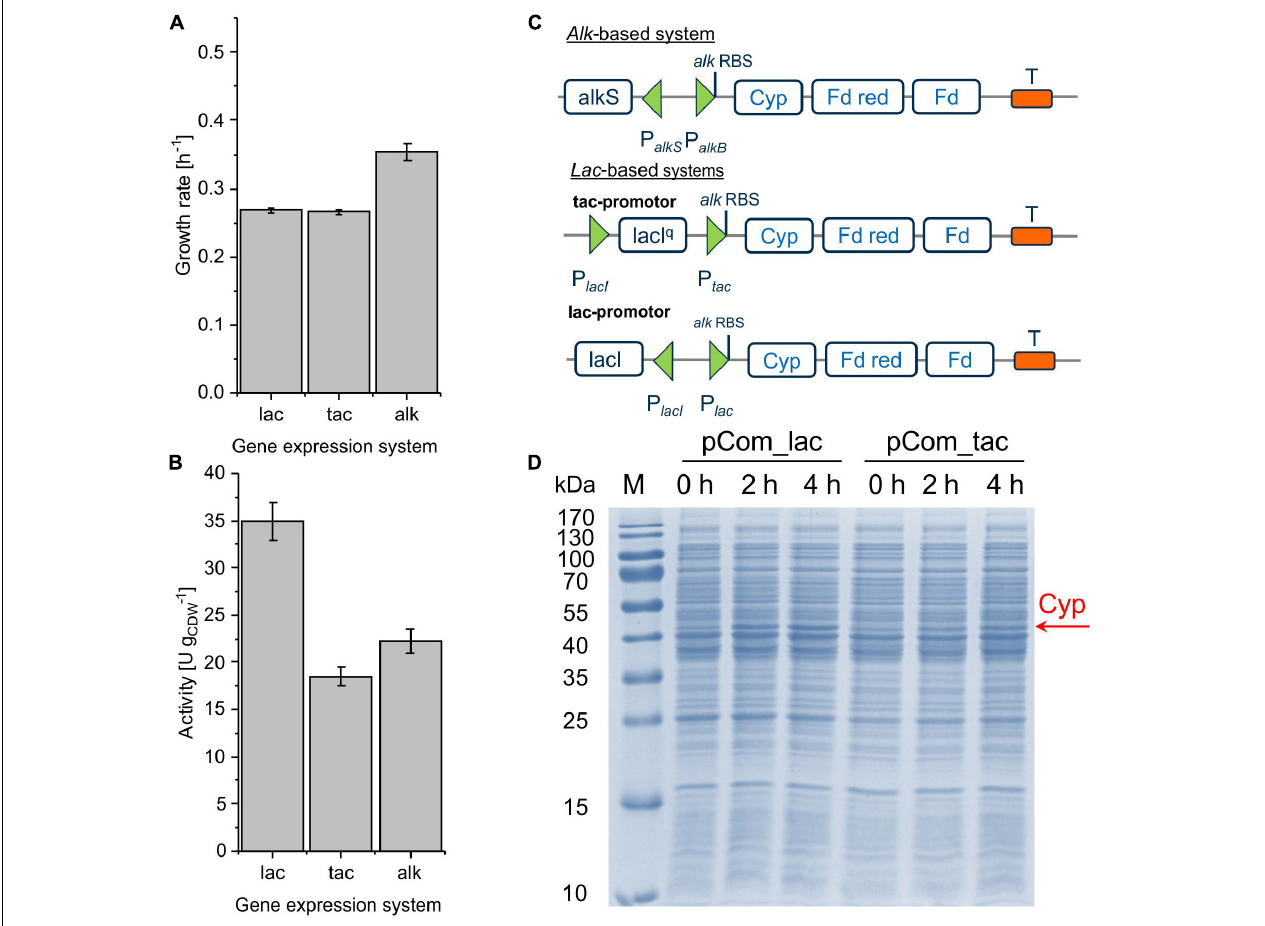
FIGURE 2 | Growth rate (A) and specific cyclohexane hydroxylation activity (B) of P. taiwanensis VLB120 harboring pCom10_lac_Cyp, pCom10_tac_Cyp, or pCom10_Cyp after 4 h of induction. Cells were cultivated in M9 ∗ medium with 0.5% (w/v) glucose ( lac and tac ) or citrate ( alk ) and resuspended to biomass concentrations of 0.2 and 1.0 g CDW L − 1 in Kpi buffer supplemented with 1% (w/v) glucose or citrate, respectively. Reactions were started by adding 10 µ L pure cyclohexane (180 µ M in aq. phase) and stopped after 10 min by quenching with diethyl ether (see section “Materials and Methods” for details). The bars represent average values. Standard deviations of two independent biological replicates are given. The average experimental errors over all measurements for the growth rate and activity are 2.1 and 5.5%, respectively. Panel C illustrates the constructs applied (Cyp: Cytochrome P450 monooxygenase, Fd red: Ferredoxin reductase, Fd: ferredoxin). Panel D shows the SDS-PAGE analysis of the different strains 0, 2, and 4 h after induction, with the band at 47.4 kDa representing Cyp.